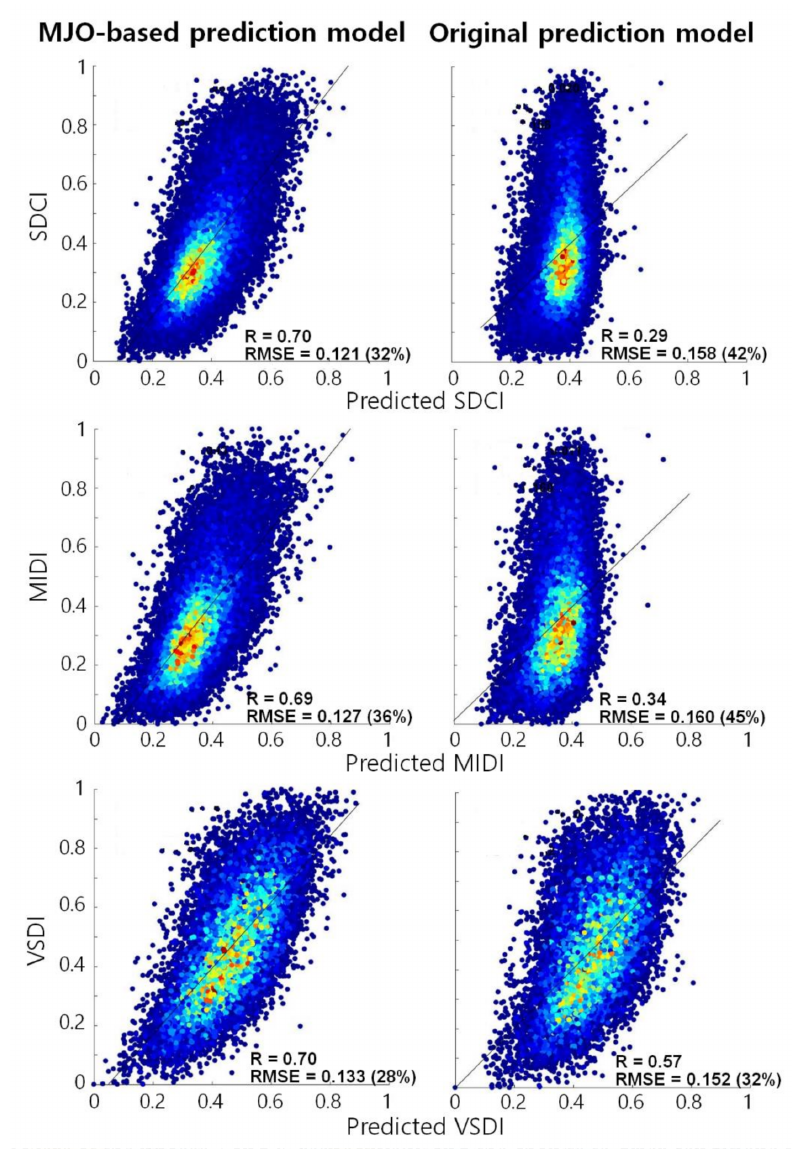
Figure 5. Modeling performances of the two drought prediction models (with MJO and without MJO) for three drought indices. Scatter plots with r, root mean square error (RMSE), and relative RMSE (rRMSE) (the percentage values mentioned in parentheses) were produced though